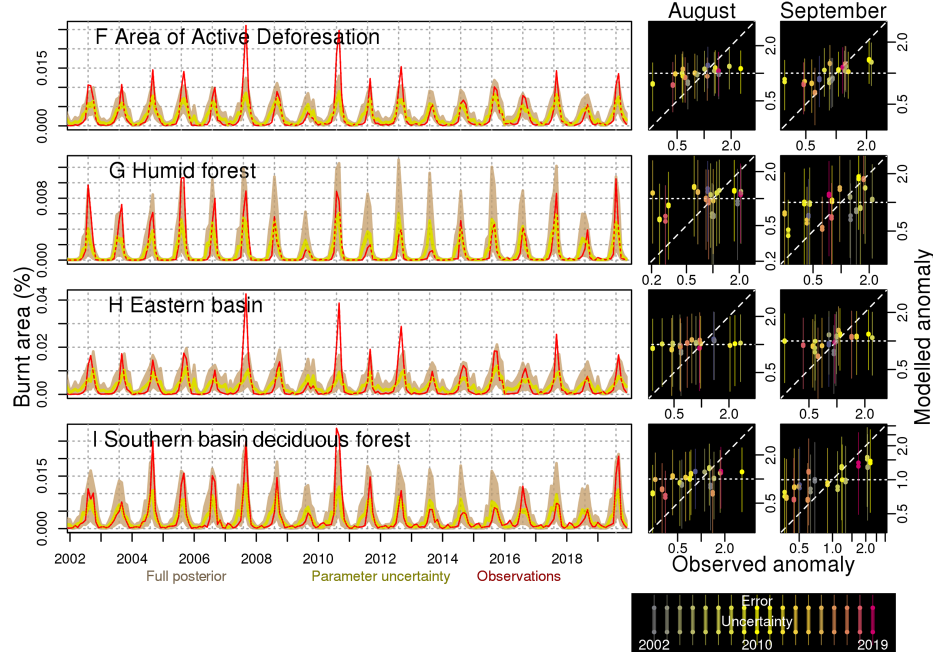
Figure 2. As Fig. 1, but for the area of active deforestation region, which incorporates areas where there has been a significant increase in agriculture and decrease in tree cover. See Fig. S4 and regions and increased agriculture and decreased tree cover in the (G) humid tropical forest, (H) savanna and (I) dry–deciduous forest.